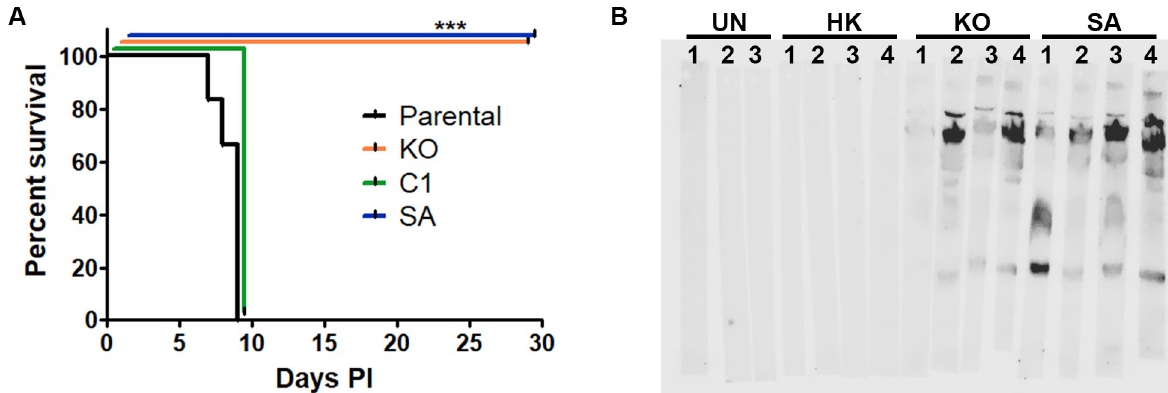
Fig 6. Δ TgPL3 and S1409A parasites are avirulent. (A) Shown is a combination of two independent experiments of 3–4 NMRI mice each, either all male or all female, with a total of 7 mice per strain. Mice were infected with 1000 T . gondii parasites and survival was monitored for 28 days post infection. No brain cysts were seen in surviving mice. ��� p < 0.001. (B) Serum collected 28 days post infection in surviving mice tested for seropositivity with individual strip blots for each mouse (labeled 1, 2, 3 or 4). Seroconversion was seen in all Δ TgPL3 and S1409A infected mice but not in uninfected mice (UN) or mice infected with heat-killed parasites (HK). Shown is a representative of two independent experiments.